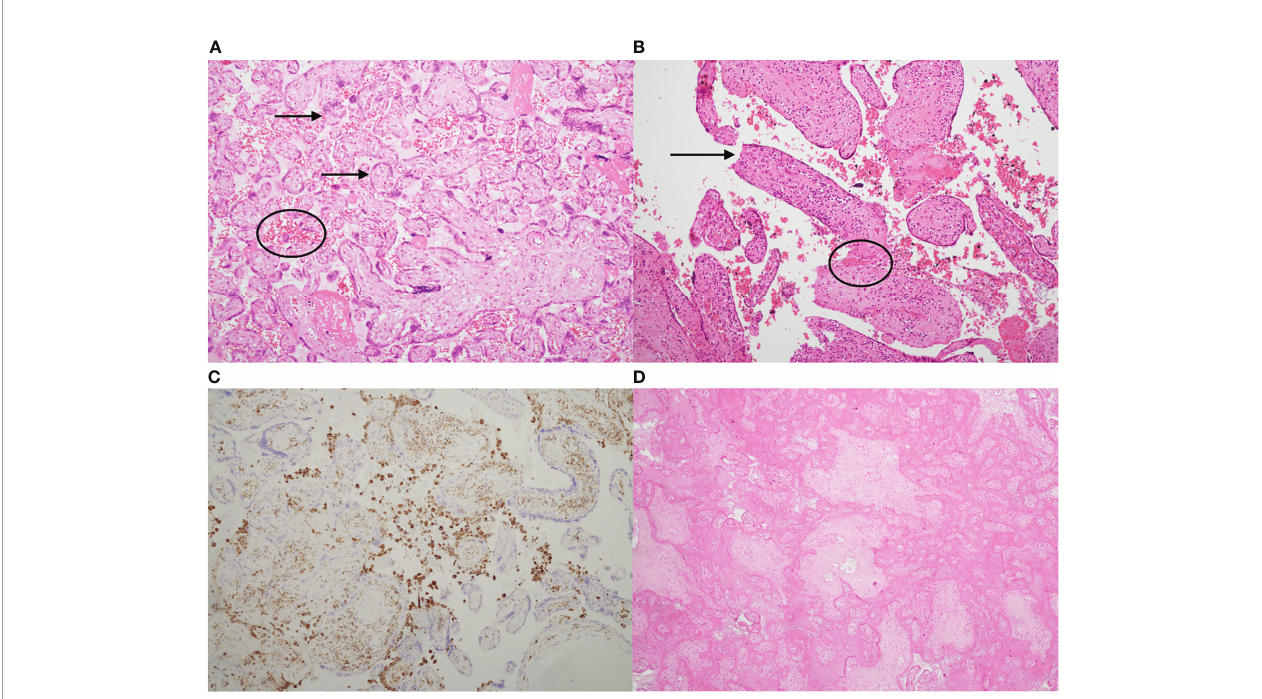
FIGURE 1 | Typical histological appearances of villitis of unknown etiology (VUE), chronic histiocytic intervillositis (CHI) and massive perivillous fi brin deposition (MPFD). (A) Haematoxylin & eosin stain of a slide showing normal placenta at 35 weeks ’ gestation, with normal chorionic villi (arrows) and maternal erythrocytes in the intervillous space (circled). (B) Haematoxylin & eosin stain demonstrating VUE. There is an excess of stromal T lymphocytes, villous agglutination (circled) and loss of trophoblast integrity (arrow). (C) Chronic histiocytic intervillositis. Immunohistochemistry demonstrates presence of CD68+ maternal histiocytes (brown) in the intervillous space. (D) Massive perivillous fi brin deposition (MPFD), with >95% of the intervillous space obliterated by fi brin. There is also villous agglutination and loss of nuclear integrity. (A,B) , x10. (C) , x2. (D) ,